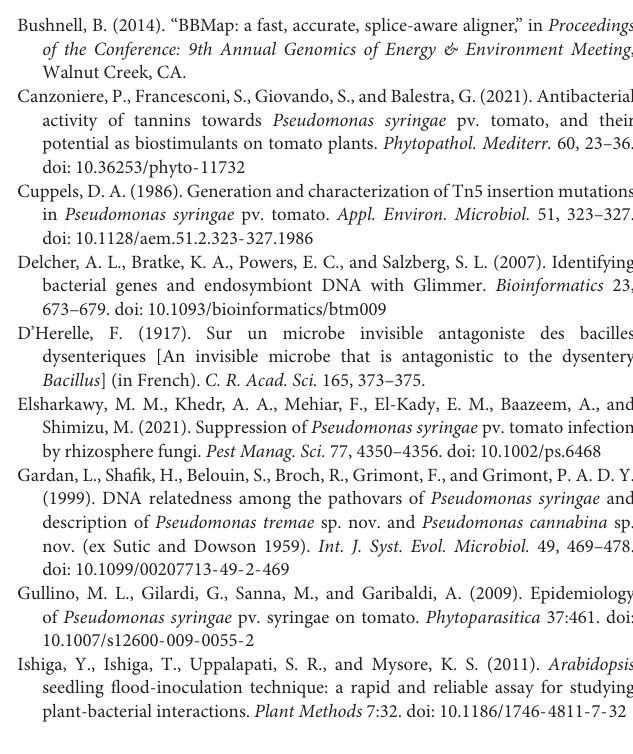
Supplementary Table 1 | Predicted ORFs and their functional annotation in the genome of Pseudomonas phage Eir4. Putative Shine-Dalgarno sequences 20